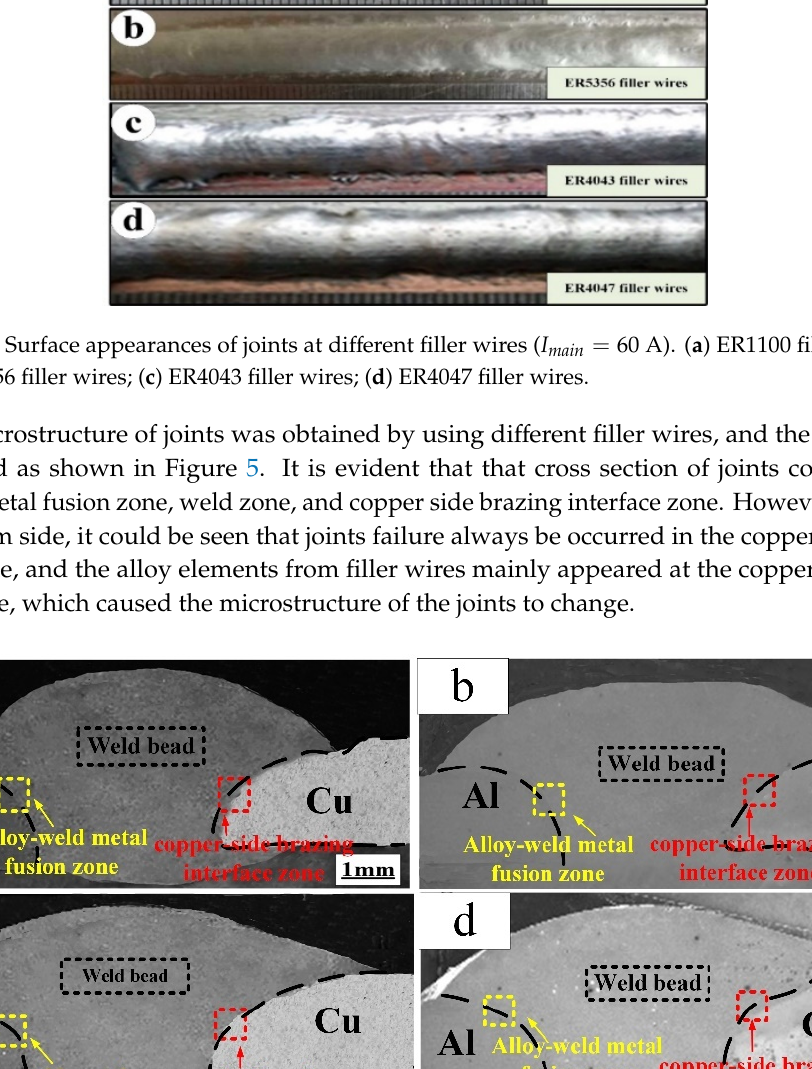
= 60 A ). ( a ) ER1100 filler wires; ( b ) ER5356 filler wires; (cid:3040)(cid:3028)(cid:3036)(cid:3041)